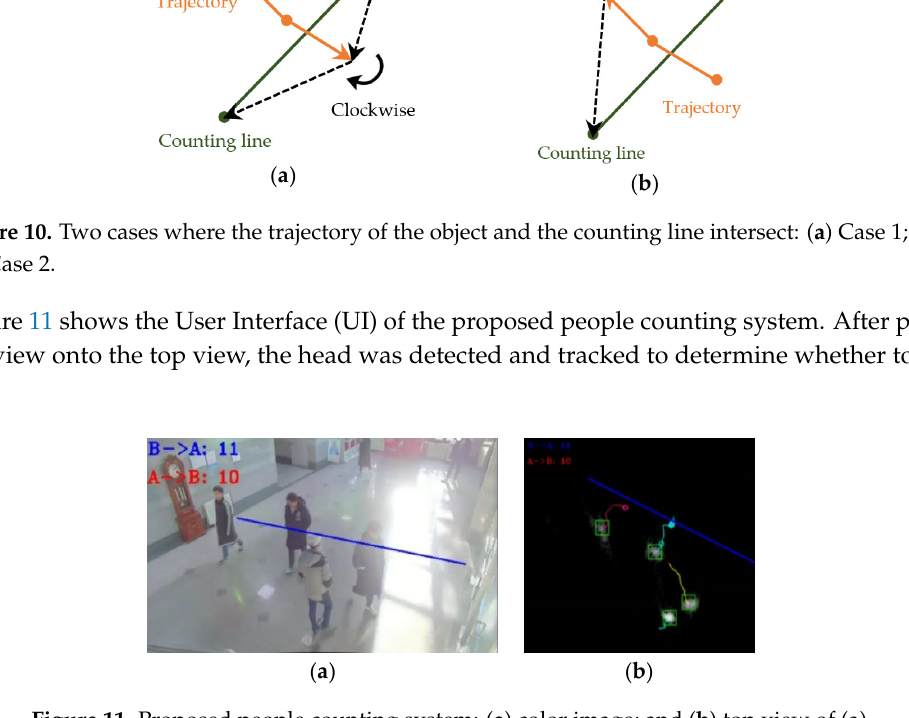
Figure 11. Proposed people counting system: ( a ) color image; and ( b ) top view of (a).